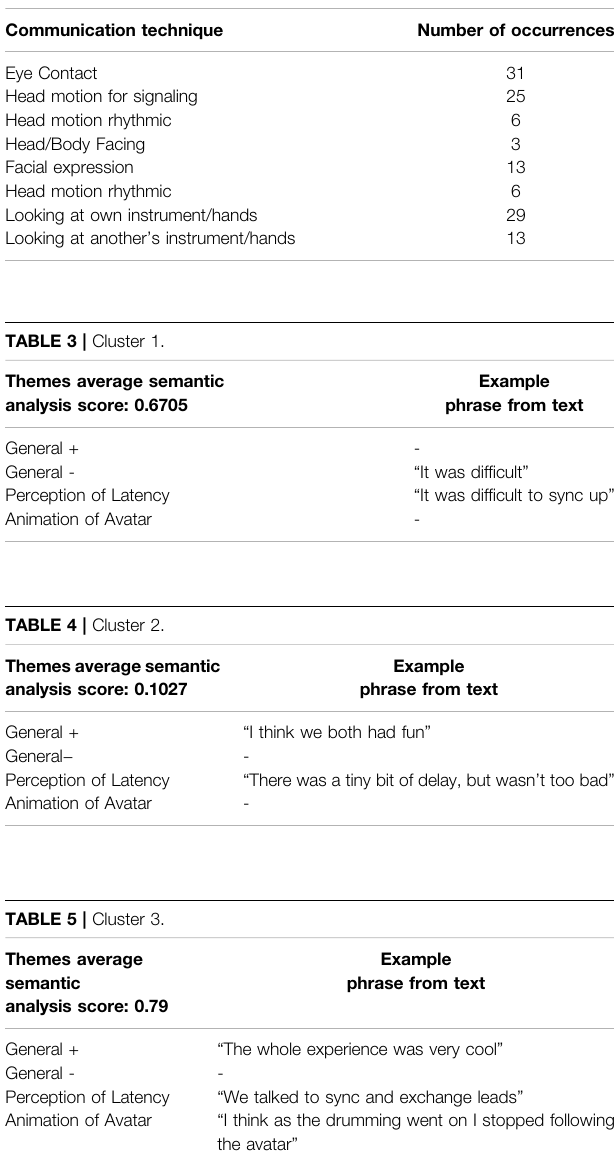
TABLE 2 | Summary of communication techniques.